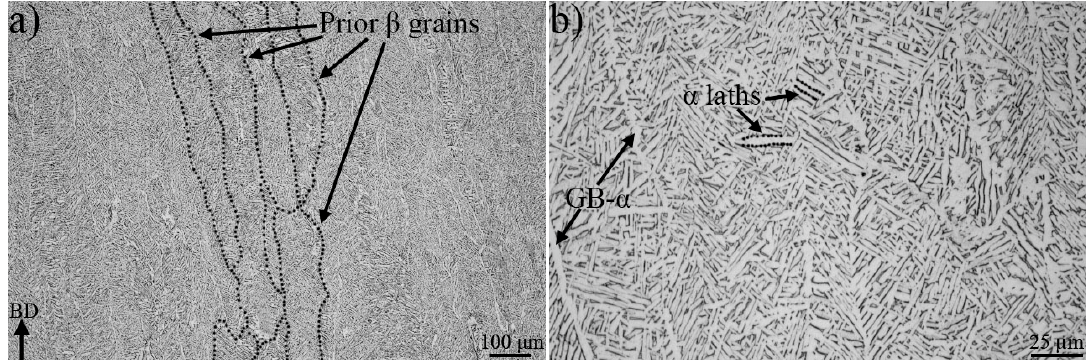
Figure 2. In ( a ) columnar prior β grains and in ( b ) the basketweave microstructure are shown. The black arrow in the bottom left corner in ( a ) points towards the build direction (BD).